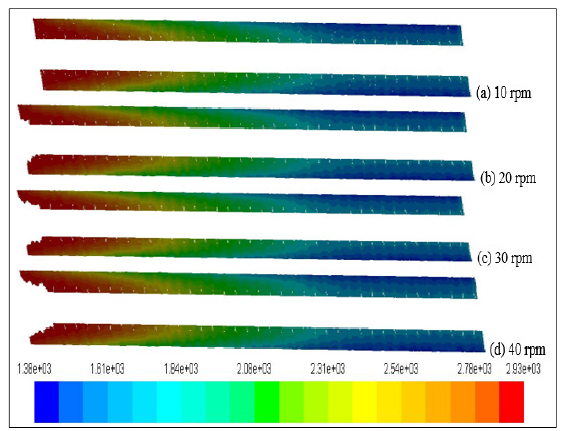
Fig. 11. Viscosity Contour plane at 500 gm.